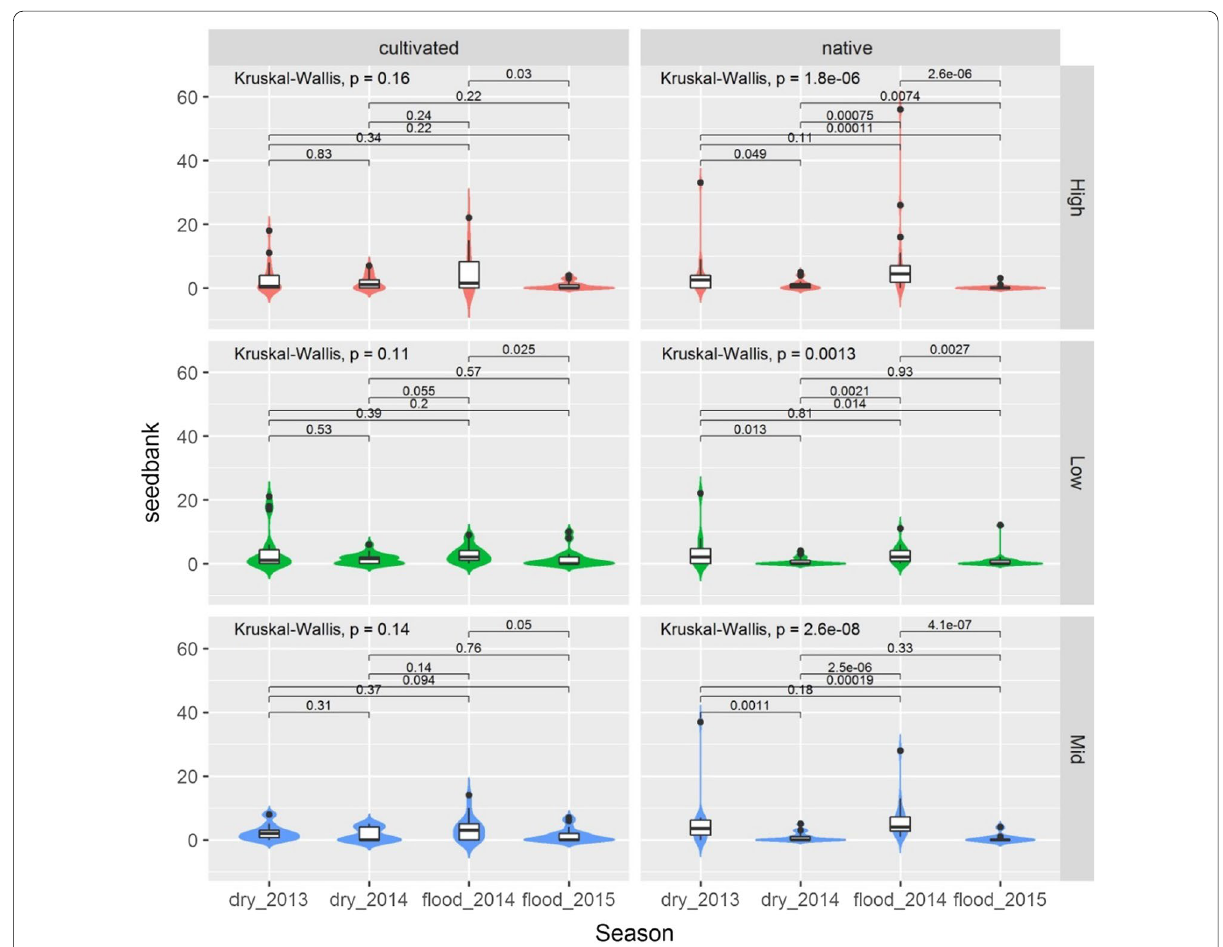
Fig. 3 Differences in number of seed in topsoil bank between seasonal flood disturbance (post-flood and post-dry disturbance) by type of grasslands (native and cultivated) and topographical conditions (low, mid, high), Pantanal wetland. We classified the topographical gradient into three levels: (1) low–longer duration of flood; (2) mid–intermediate level; and (3) high–short duration of flood. Differences at posteriori analyses are indicated (Dunn test, p <